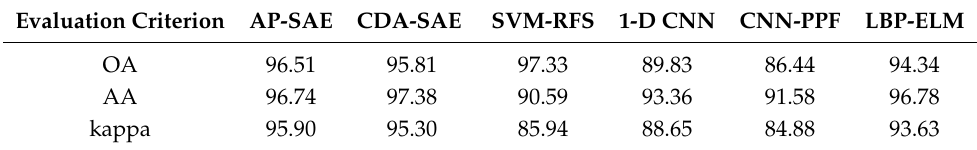
Table 8. Performance Comparison of Different Thresholds for Indian